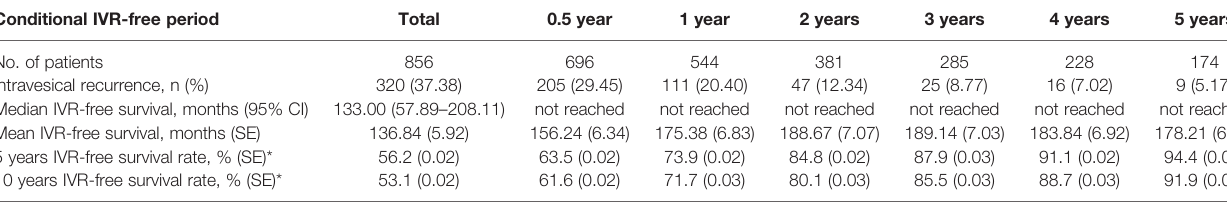
TABLE 3 | Conditional intravesical recurrence-free survival after radical nephroureterectomy with bladder cuff excision. Conditional IVR-free period